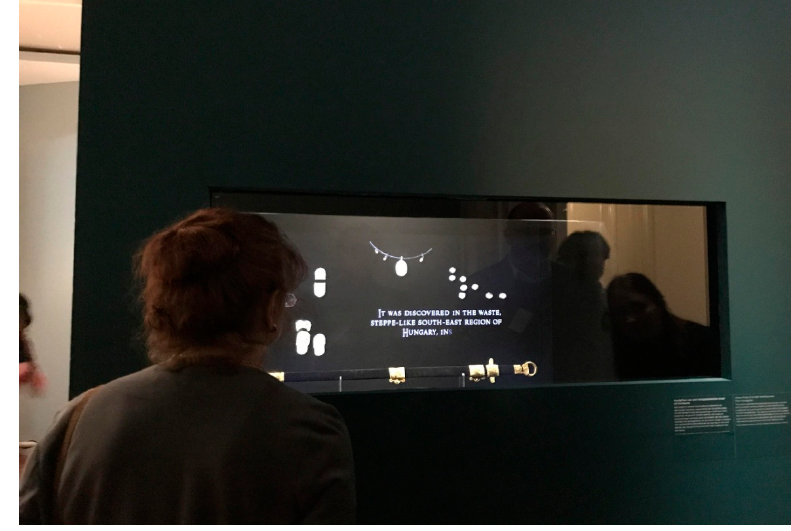
Figure 13. Kun à gota sword, first chapter. Neutral vision. (https://vimeo.com/221057009; https: